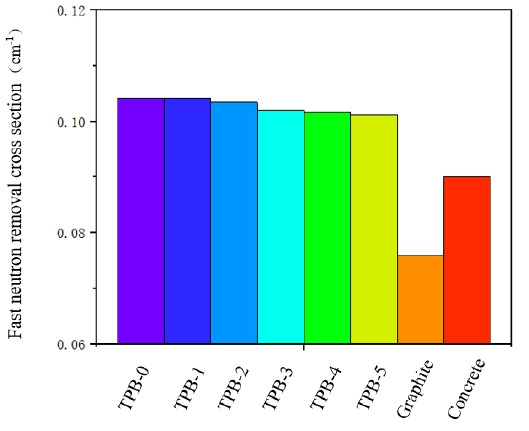
Figure 8. Removal cross section (RCS) of TPB series glass, graphite, and ordinary concrete.